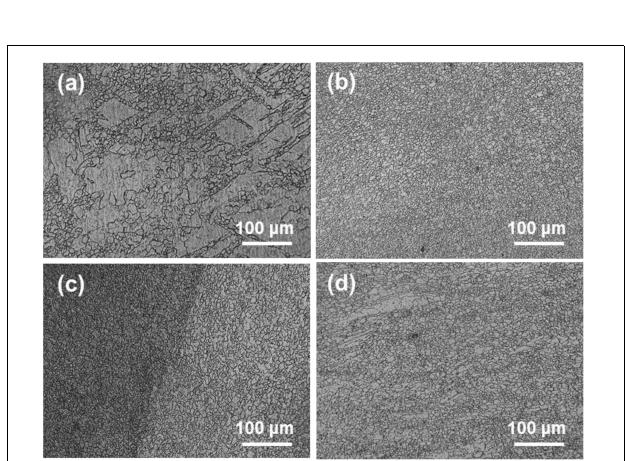
FIGURE 7 | OM of (a) AZ31 alloy, (b) SZ-center, (c) SZ/thermo-mechanically affected zone, and (d) TMAZ in FSPed AZ31/ZrO 2 composite (Z3-3P specimen).